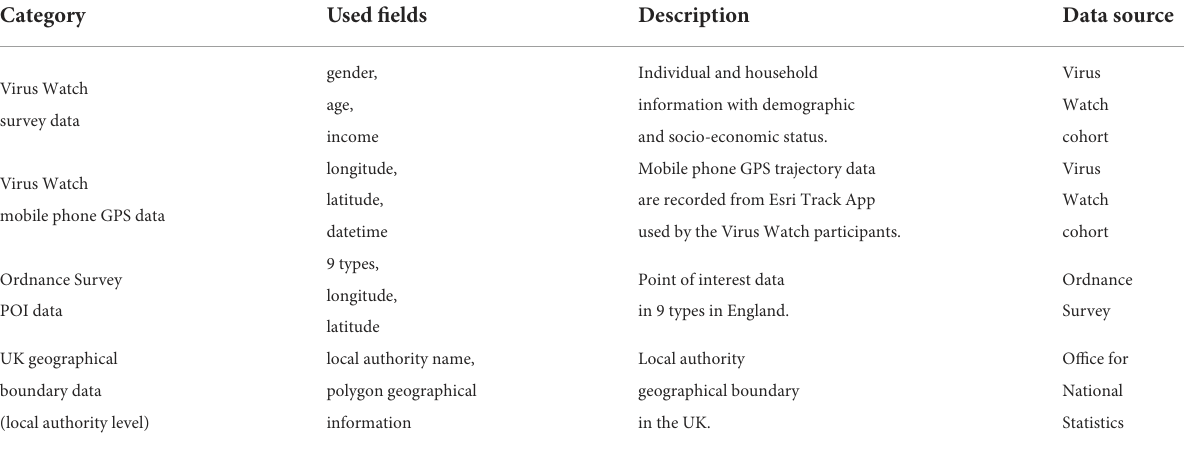
TABLE 1 A summary of data sources.